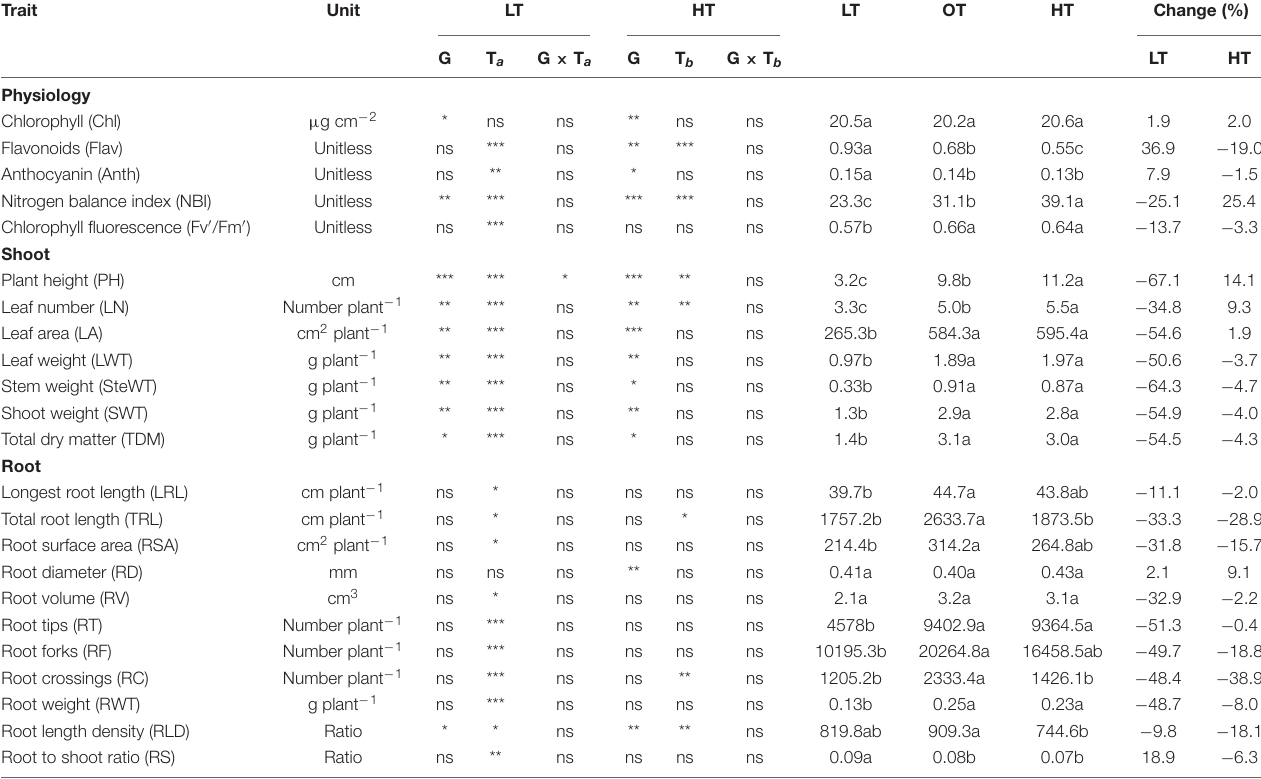
TABLE 2 | Summary of ANOVA across the genotype (G), temperature treatments (T), and their interaction (G × T) on a different shoot, root, and physiological traits measured 35 days after planting (24 days after temperature treatments imposition). Trait